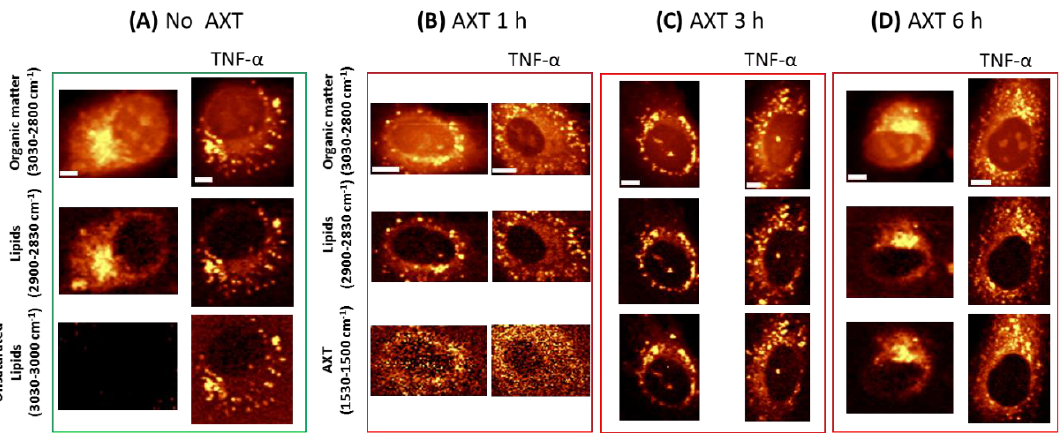
Figure 2. Representative Raman images of HAoEC cells: without and with AXT treatment and treated with tumor necrosis factor alpha (TNF- α ) ( A ),cells treated with tumor necrosis factor alpha (TNF- α ) (right part of each panel) followed by AXT stimulation for 1 h ( B ), 3 h ( C ) and 6 h ( D ), obtained by the integration of Raman bands over the selected spectral regions: 3030–2830 cm − 1 (organic matter), 2900–2850 cm − 1 (lipids), 3030–3000 cm − 1 (unsaturated lipids) and 1530–1500 cm − 1 (AXT). Scale bars equal 5 µ